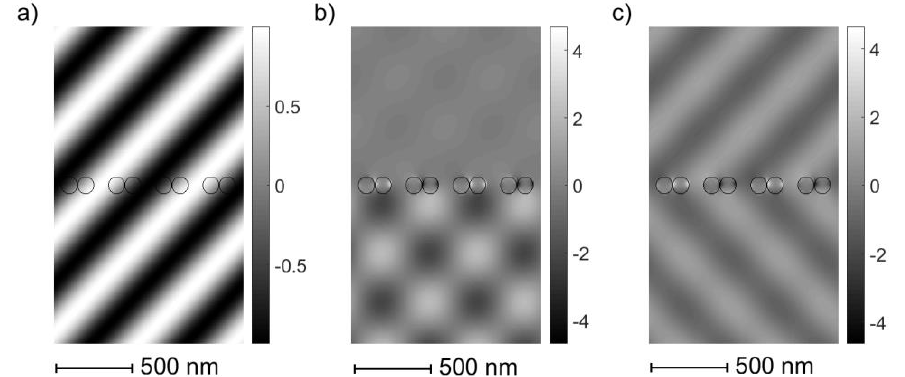
Fig. 2. The spatial distribution of the z -component of magnetic field for propagation constant β = 0: (a) incident wave, λ = 440 nm and incident angle θ = 45°, (b) response of the system and (c) total field. The geometrical parameters are: a = 311 nm, b = 2 nm and R = 53